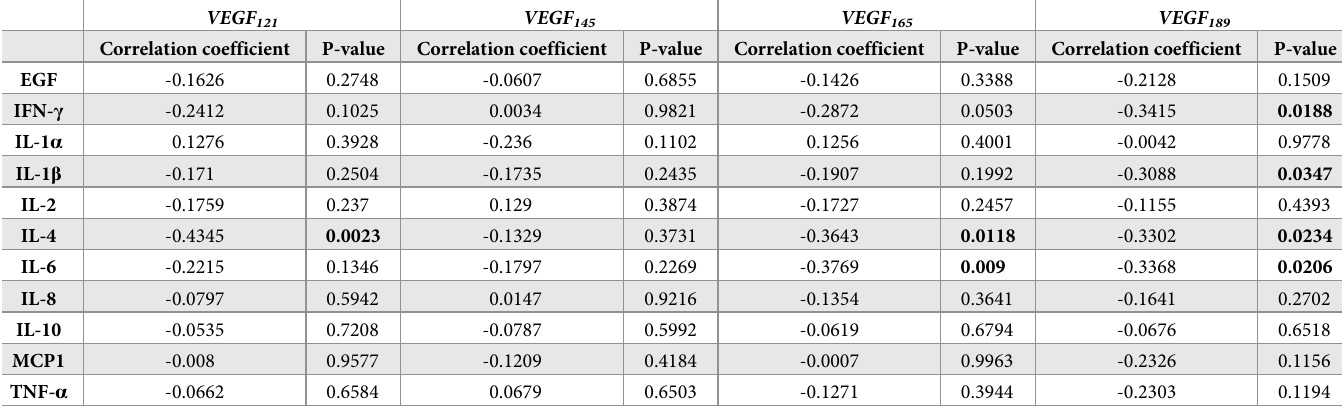
Table 5. Correlation analysis between VEGF isoforms and inflammation